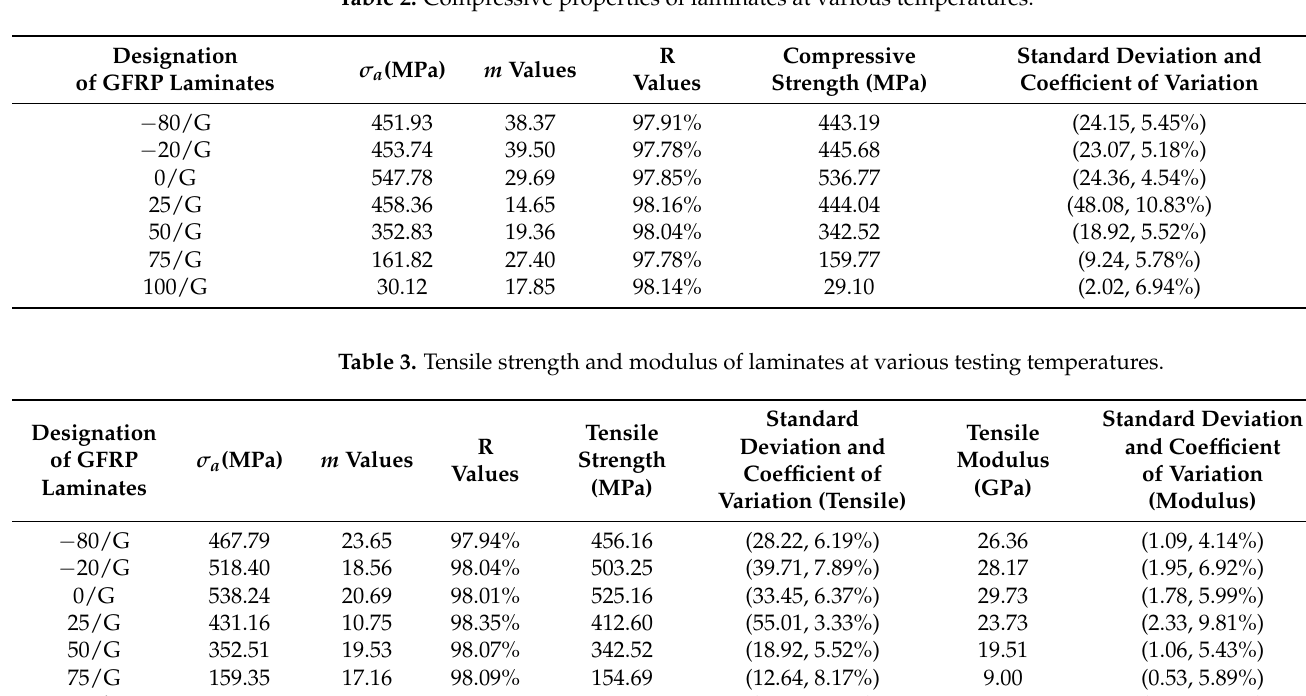
Table 2. Compressive properties of laminates at various temperatures.